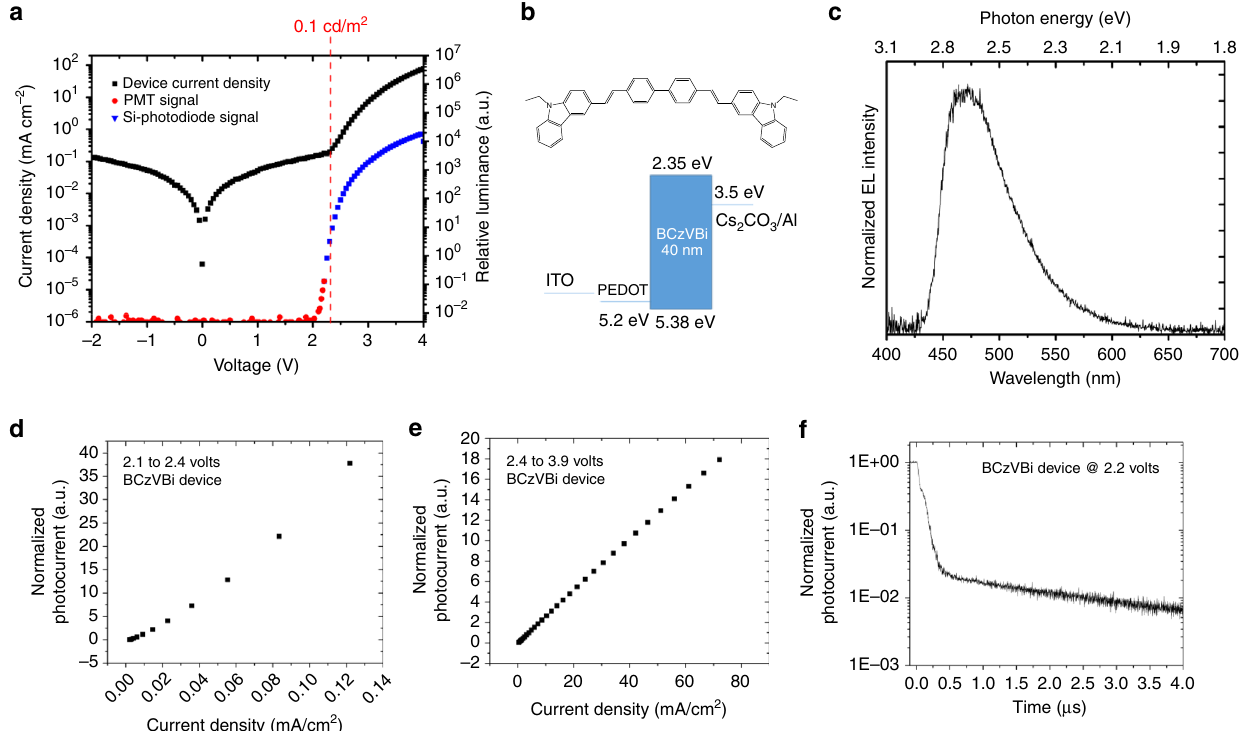
Fig. 2 Single layer BCzVBi device. a Current density and relative luminance versus voltage. b Molecular structure of BCzVBi and the energy level diagram of the corresponding single layer device. c EL spectrum. d Photocurrent vs. current density in the low-voltage region and e in the high-voltage region. f Transient EL dynamics of the device after turn-off